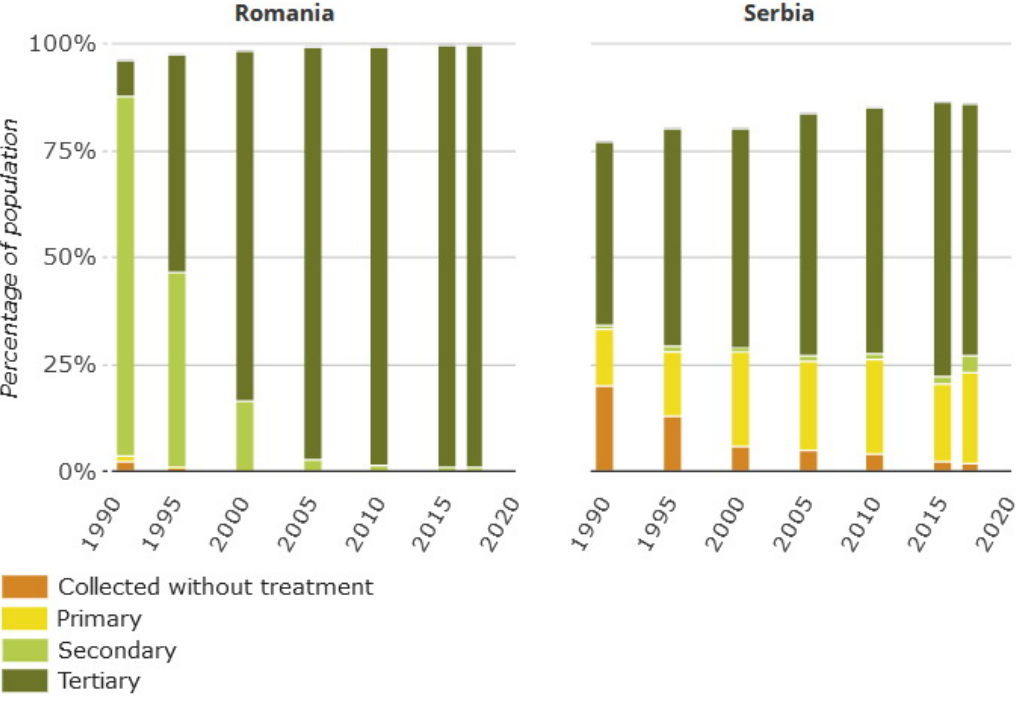
Figure 6. Urban waste water collection and treatment in Romania and Serbia, 2017 [57].